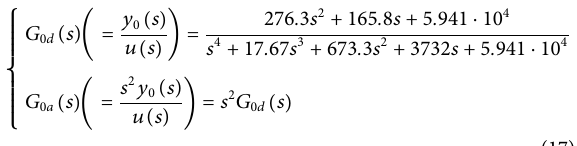
table parameters in this case became approximately 1/5 of c 0 b and k 0 b , indicating that they were affected by the structures placed.